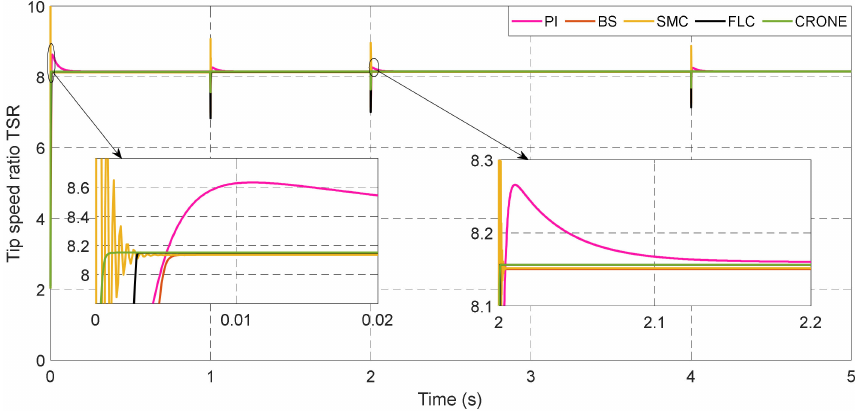
Figure 13. Tip speed ratio for PI, BS, SMC, FLC, and CRONE controllers.